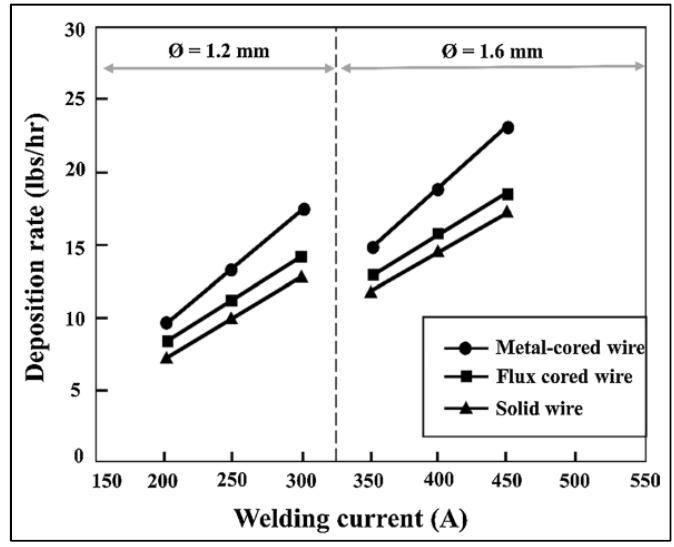
Figure 1. Deposition rates of filler wires: solid vs. flux-cored vs. metal cored [20].